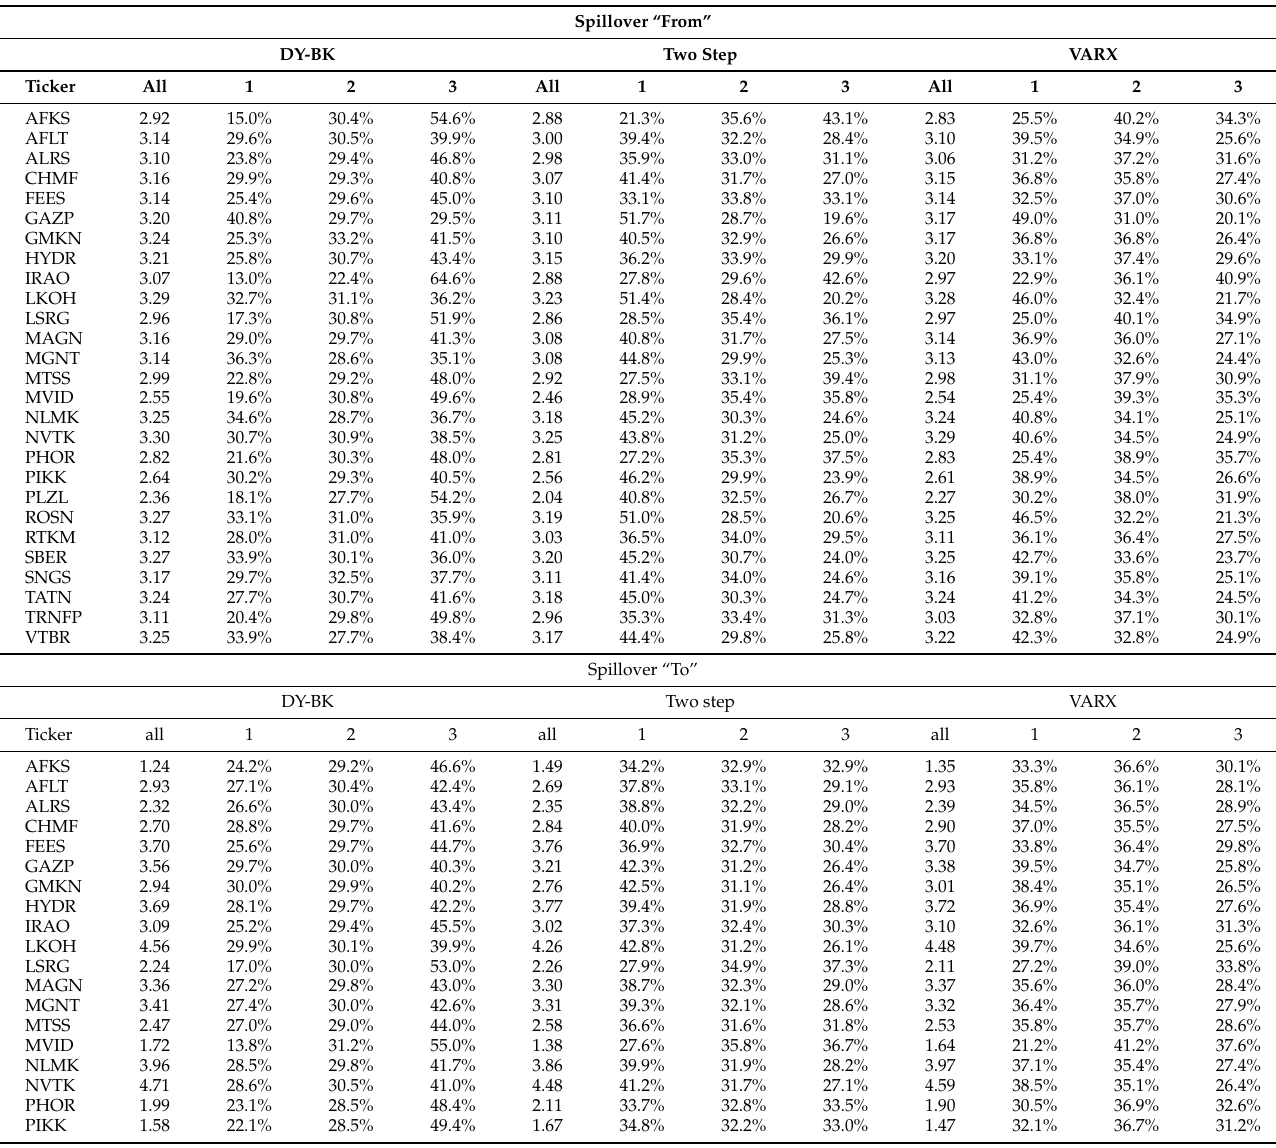
Figure 2. The value of the R 2 for regression models. The values of the conditional spillover measures, were obtained using the VARX and TS approaches, and us allowed to come to the following conclusions. The total value of NET- effects is not very sensitive to the model’s specification, but the frequency decomposition of volatility depends on whether exogenous variables are included in the model or not. A more detailed analysis of this phenomenon is presented in the next section. Table 3 presents the decomposition of connectedness. Table 3. The decomposition of